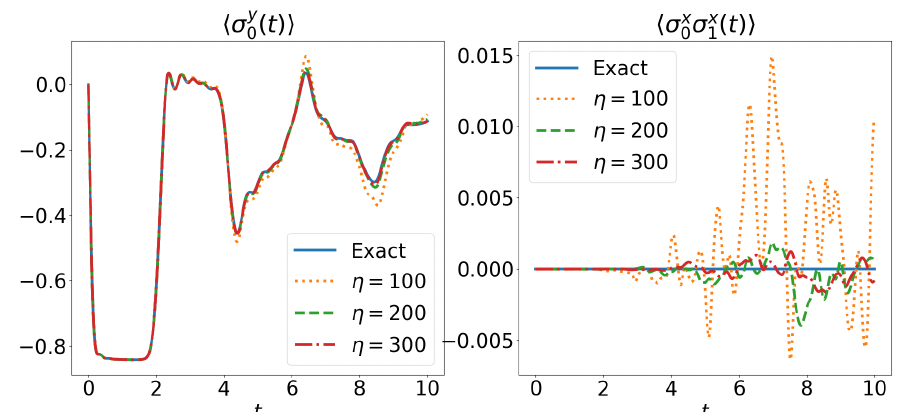
Figure 16: The Y expectation value for qubit 0 (left), and the two-qubit X X expec- tation value for qubits 0 and 1 (right), for N = 11 qubits with energy relaxation = 0.1 as in Eq. (32), and the other parameters as in Figs. 2-3. A few parameter g 0 solutions are shown vs. the time t , simulated by using both a numerically exact sim- ulation (storing the full density matrix), and the MPO approximated simulation with different maximal bond dimension η , with the convergence towards the exact solu- tion with increasing η is clearly